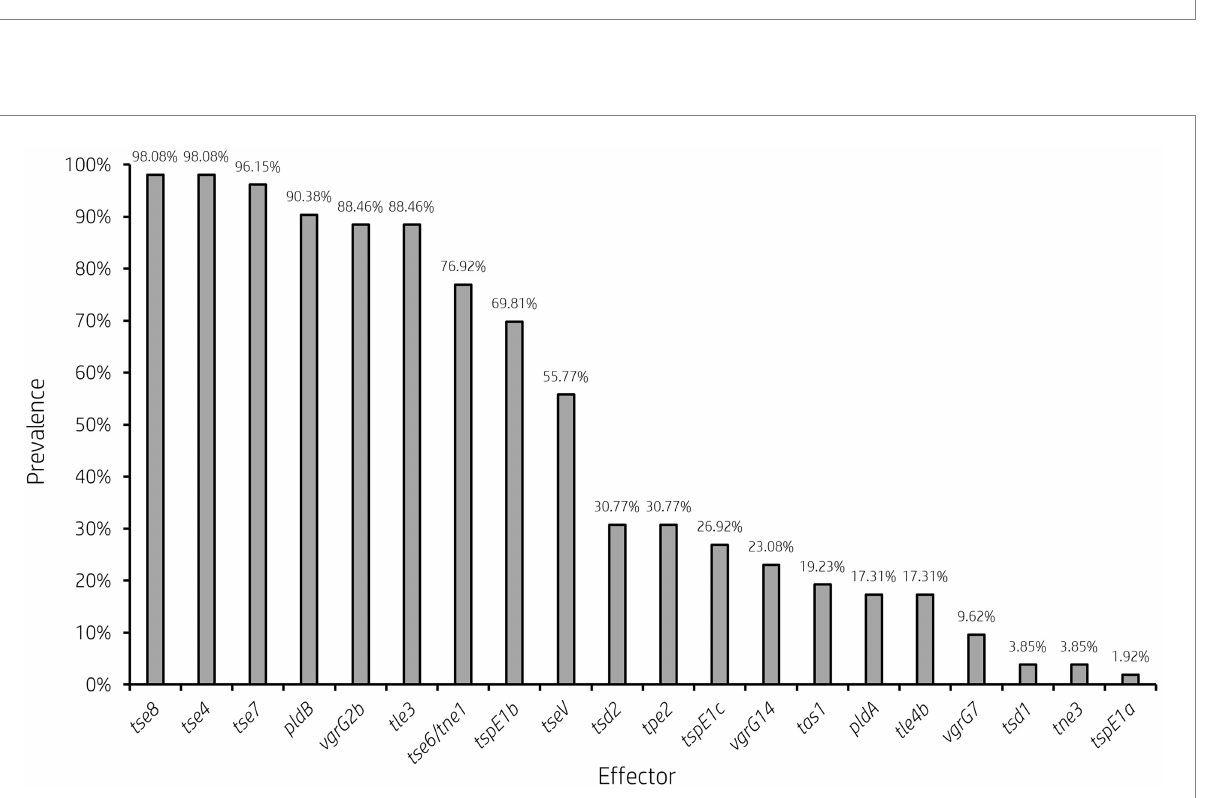
FIGURE 4 Identification of vgrG7 and the vgrG7 island. Genome sequence alignment between PAO1, PAK and clinical isolate PALA1 identifies the vgrG7 island that contains tle2 / tli2 which encodes a putative lipase effector and immunity pair.